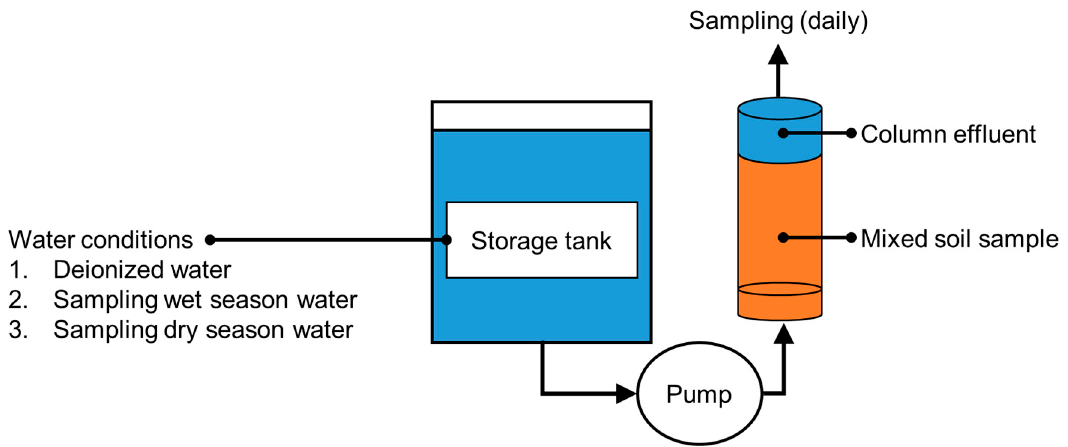
Figure 2. Schematic diagram of the column ‐ leaching test (adapted from [37]).